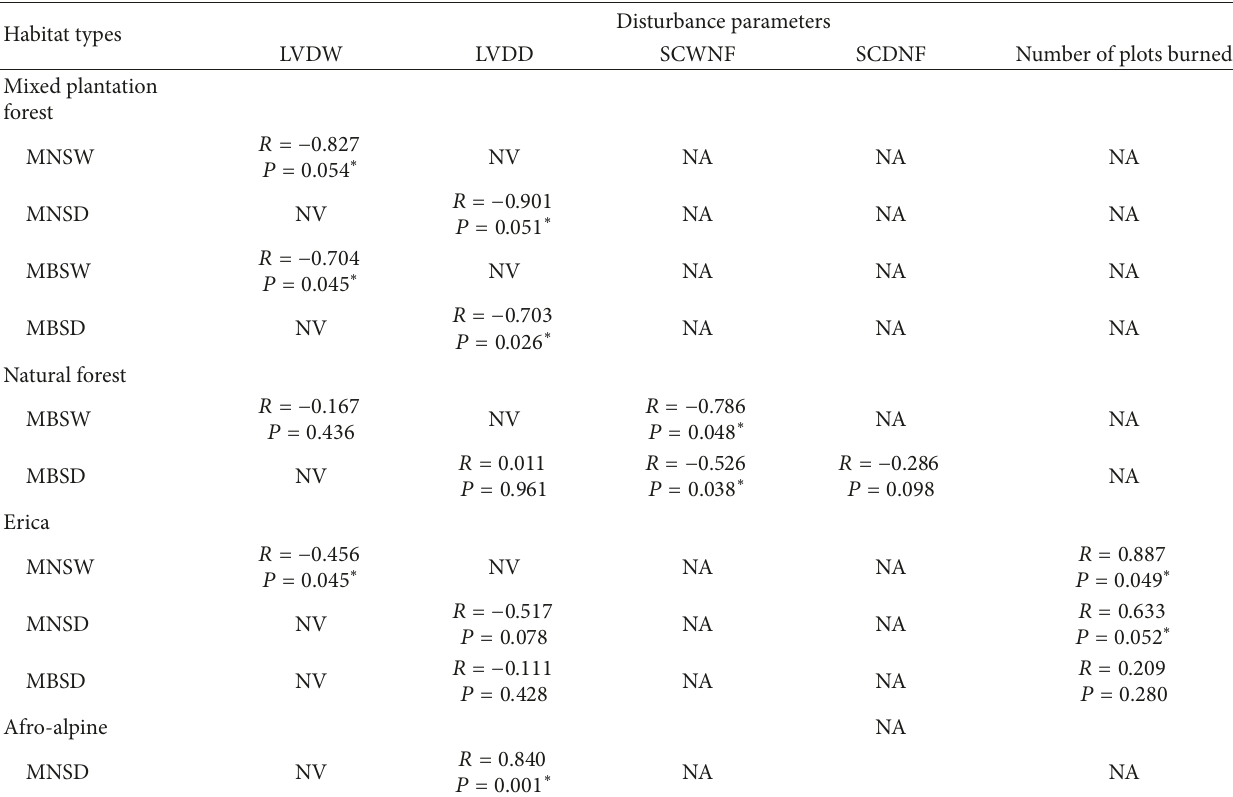
Table 2: Pearson’s correlation between mountain nyala and Menelik’s bushbuck scat counts versus different disturbance parameters among dominant habitats of Galama Mountains in both dry and wet